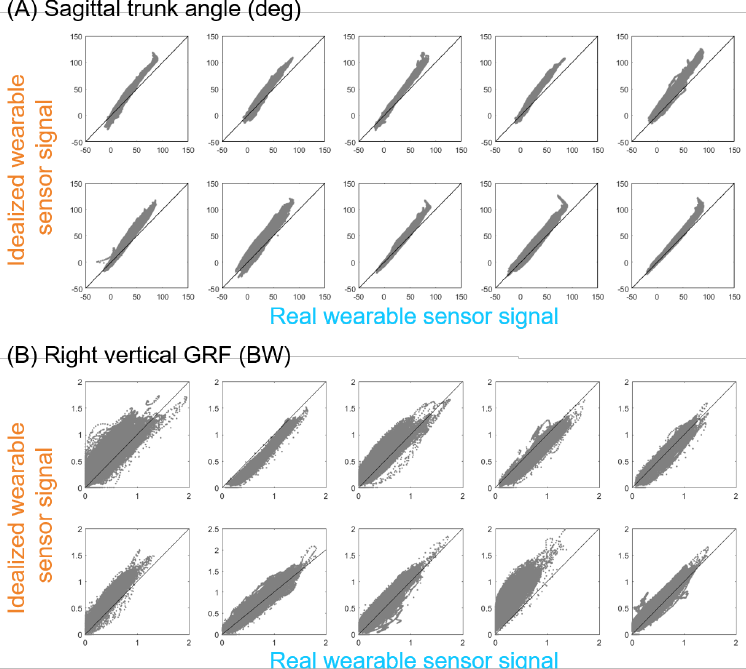
Figure A6. Trunk IMUs provided a relatively precise estimate of trunk orientation while pressure insoles provided a more variable estimate of vertical force. Ten scatter plots represent each participant and gray dots represent each time sample. Real wearable trunk orientation from an IMU correlated well with the idealized wearable trunk angle from lab-based motion capture ( A ), whereas the real wearable vertical force from pressure insoles did not correlate as well with the idealized wearable vertical force from lab-based force plates and exhibited a higher variability ( B ). A line with a slope of one is added to visualize a perfect correspondence between idealized and real wearable sensor signals. See Tables 1 and 2 for details on idealized and real wearable sensor signals. deg = degrees; BW = body weight.